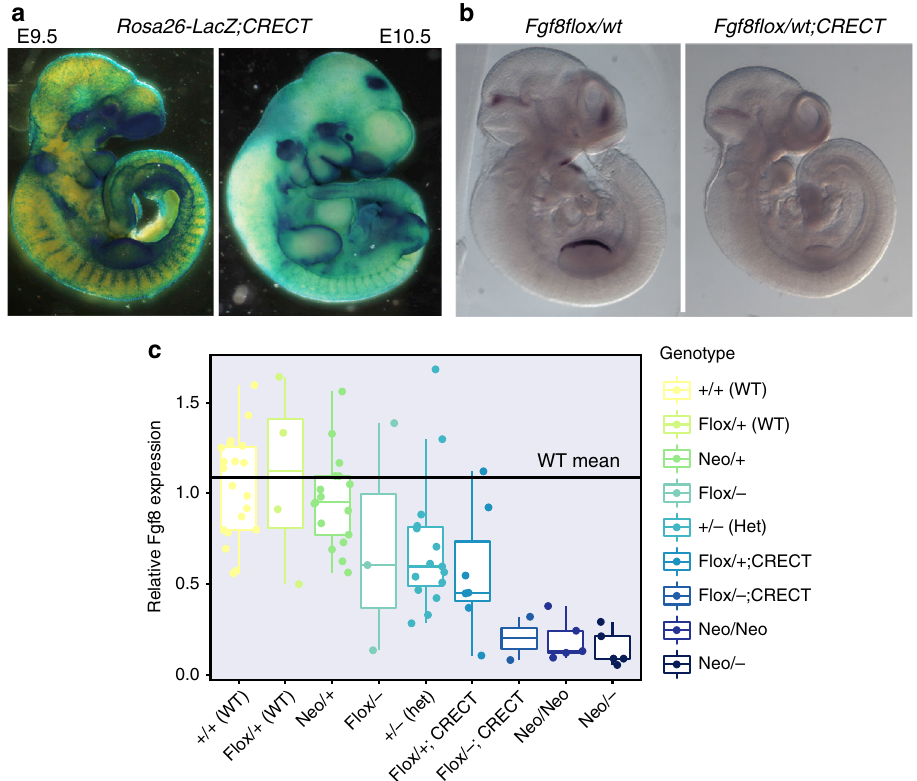
Fig. 2 Generation of the allelic series. a E9.5 and E10.5 expression of CRECT as detected by crossing CRECT males with B6;129S4- Gt(ROSA)26Sortm1Sor /J (R26R) females and staining the embryos for beta-galactosidase expression. Note the thin layer of blue present over the entire embryo showing the ectodermal CRE expression. b In situ hybridization showing regions of decreased Fgf8 in the E10.0 Fgf8 fl ox/ fl ox;Crect embryos. c qRT-PCR of cranial tissue showing Fgf8 levels by genotype; sample size is between 2 and 22 samples per group. The box represents 1.5× the interquartile range of the data. Allelic series for Fgf8 generates gradual loss of Fgf8 mRNA. Data shown is the delta – delta-CT value, where data were normalized against the mean delta-CT for the WT group. The homozygous null is not included as it is